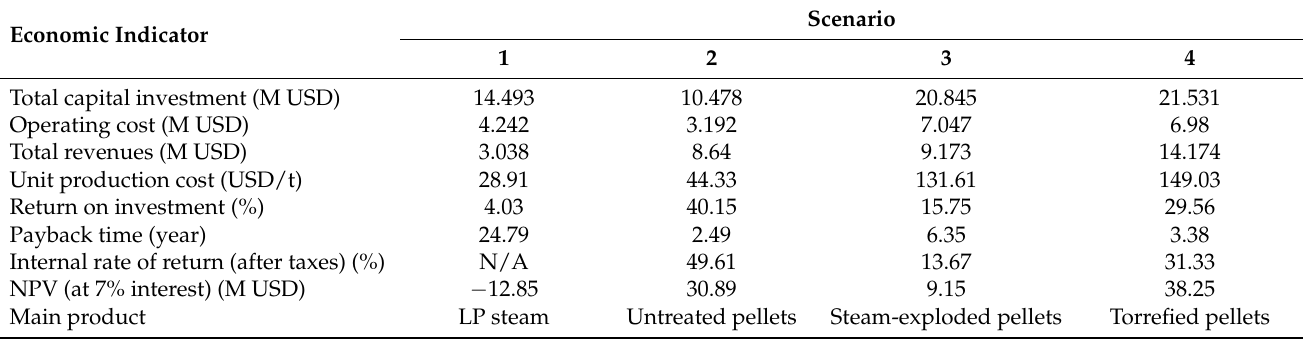
Table 4. Summary of economic indices for profitability analysis between case